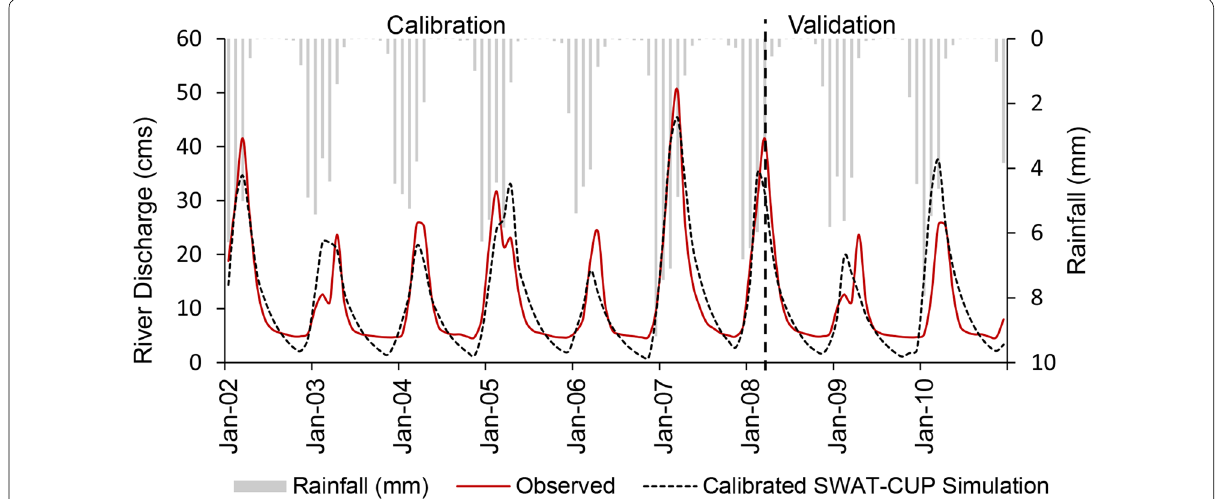
Fig. 11 Comparison between simulated and observed monthly discharge of Ndembera